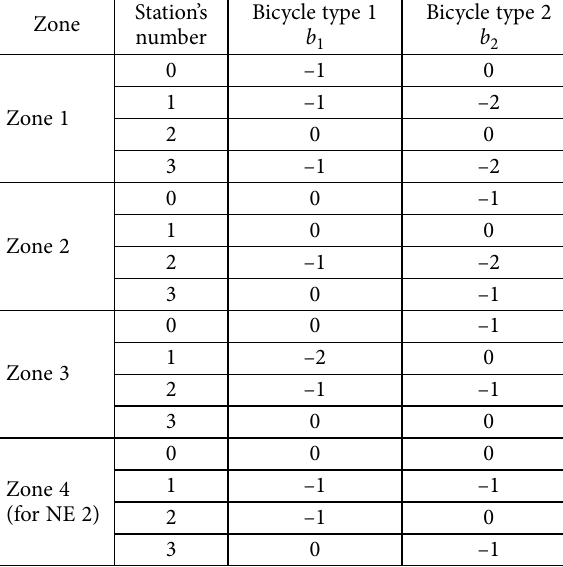
Table 7. Number of the defective bicycles within stations for both numerical examples